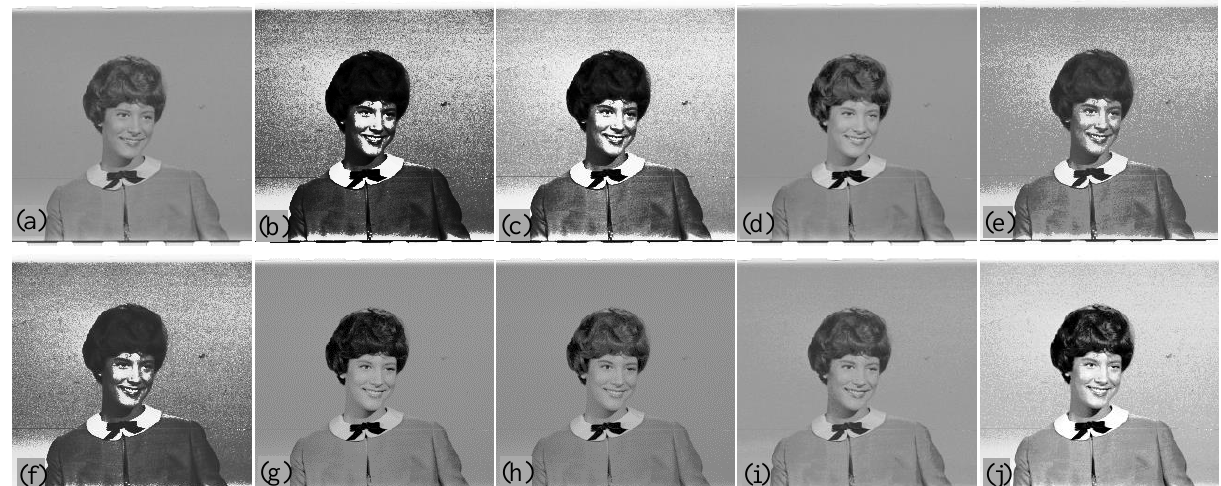
Figure 9. Girl (a) The original Image, The experimental image under study (b) The enhanced image by Histogram Equalization (c) The enhanced image by BBHE (d) The enhanced image by ABC (e) the enhanced image by RSIHE (f) The enhanced image by DSIHE (g) The enhanced image by [19] (h) The enhanced image by the proposed method (i) The enhanced image by SDDMHE (j) The enhanced image by